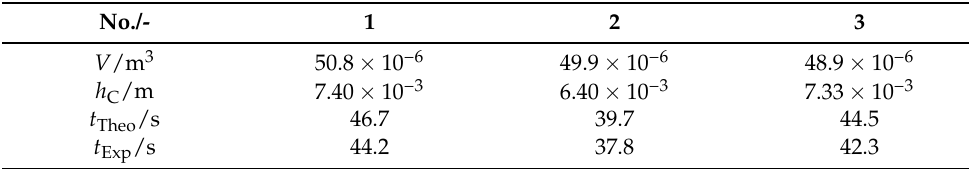
Table 1. Theoretical and experimental permeation